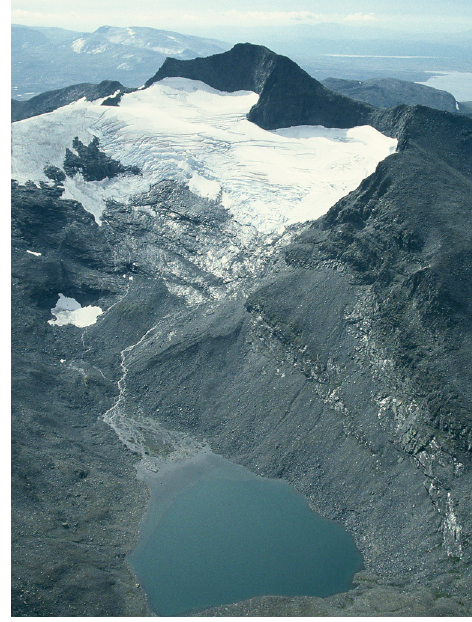
Figure 7: Left-above. Storsylglaciären (3) close to its Neoglacial Figure 6: Aerial view of Storsylglaciären (3). maximum, in 1908. Photo: Enquist (1910). Mid. By the early 21st By the early 20th century, the glacier termi- century, the glacier had lost approx. 50 % of its prior volume. nated at the small inlet delta by the progla- 2001-08-21. Right-below. Recession has continued during the first cial lake (Syltjärnen) in the foreground, decade of the 21st century. 2010-09-10. 1276 m a.s.l. 2005-08-15.